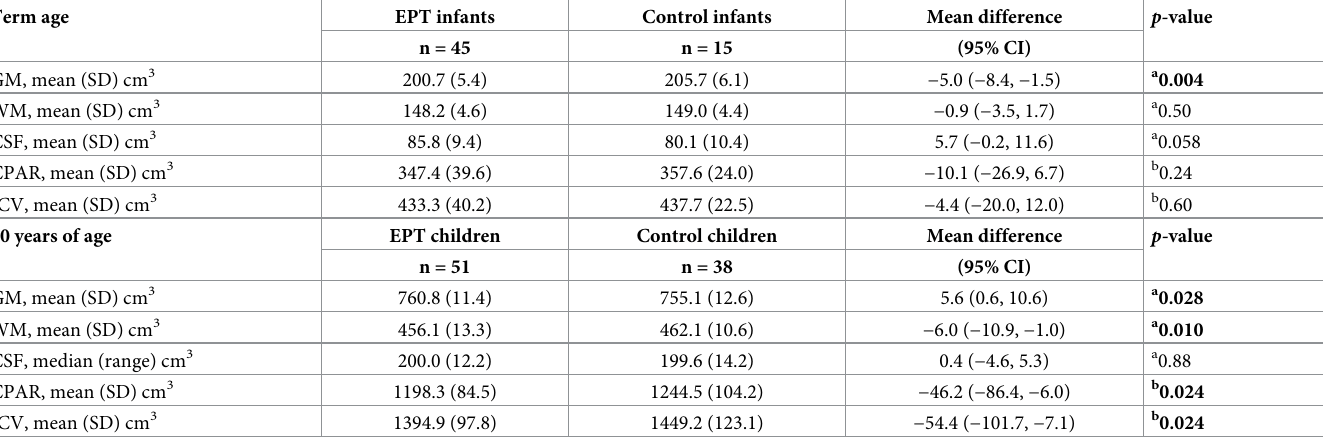
Table 2. Brain volumes at term age and at 10 years of age for included extremely preterm (EPT) infants and children, compared to control infants and